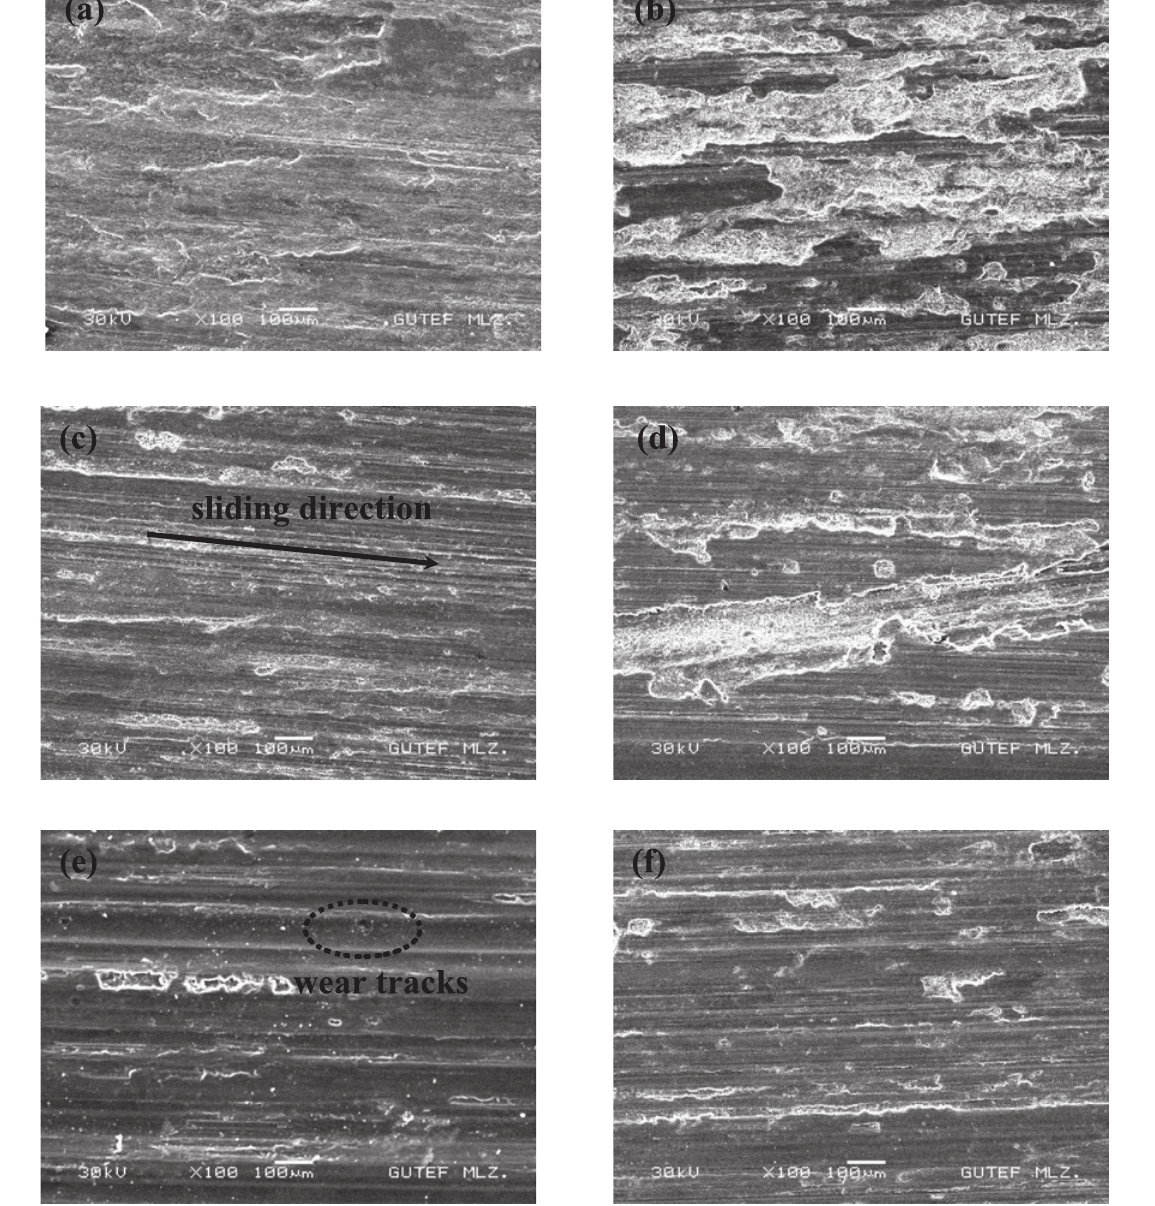
Fig. 5: Wear surface of AA6063 alloy worn at 1600 m sliding distance, SEM images T6 10N (a), T5 10N (b), T6 20N (c), T5 20N (d), T6 30N (e), T5 30N (f